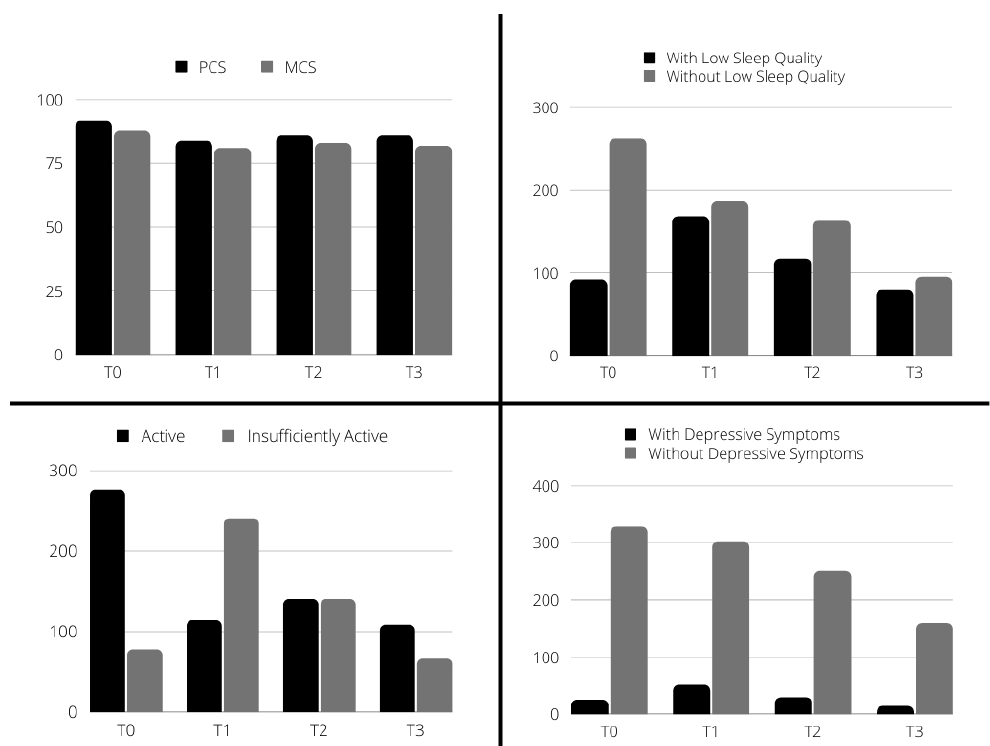
Figure A1. Changes in PCS, MCS, sleep quality, BP and depressive symptoms at different data points. T0: period before the pandemic; T1: mandatory preventive isolation; T2: selective isolation and responsible individual distancing; T3: selective isolation with responsible individual distancing and safe economic reactivation; PCS: physical health component summary; MCS: mental health component summary.